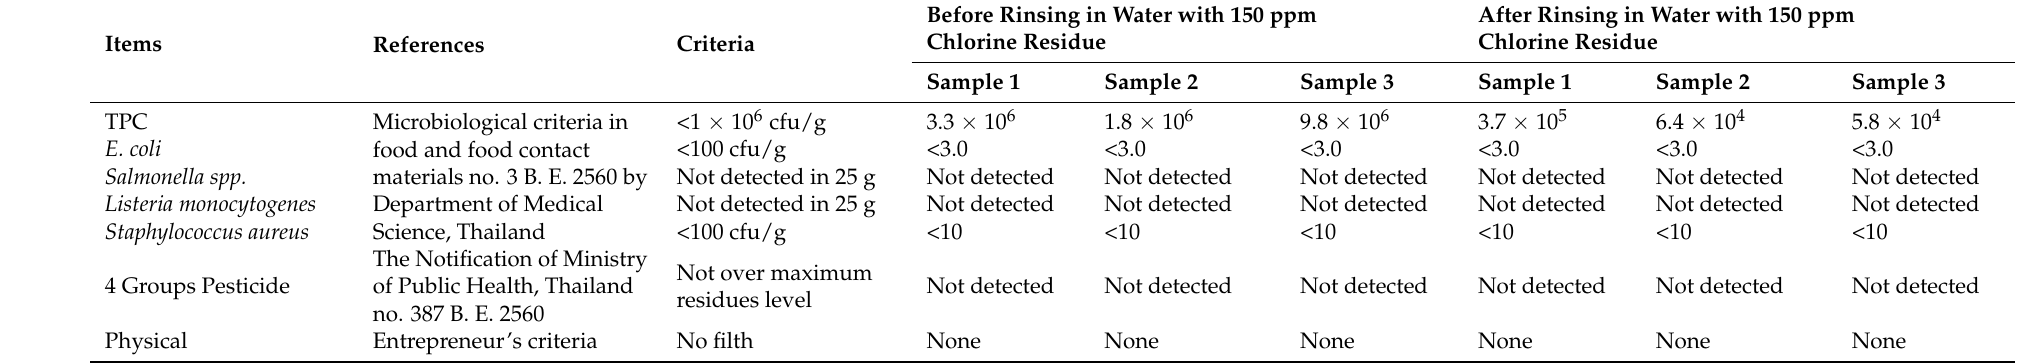
Table 8. Conventional ready-to-eat mix salads test results